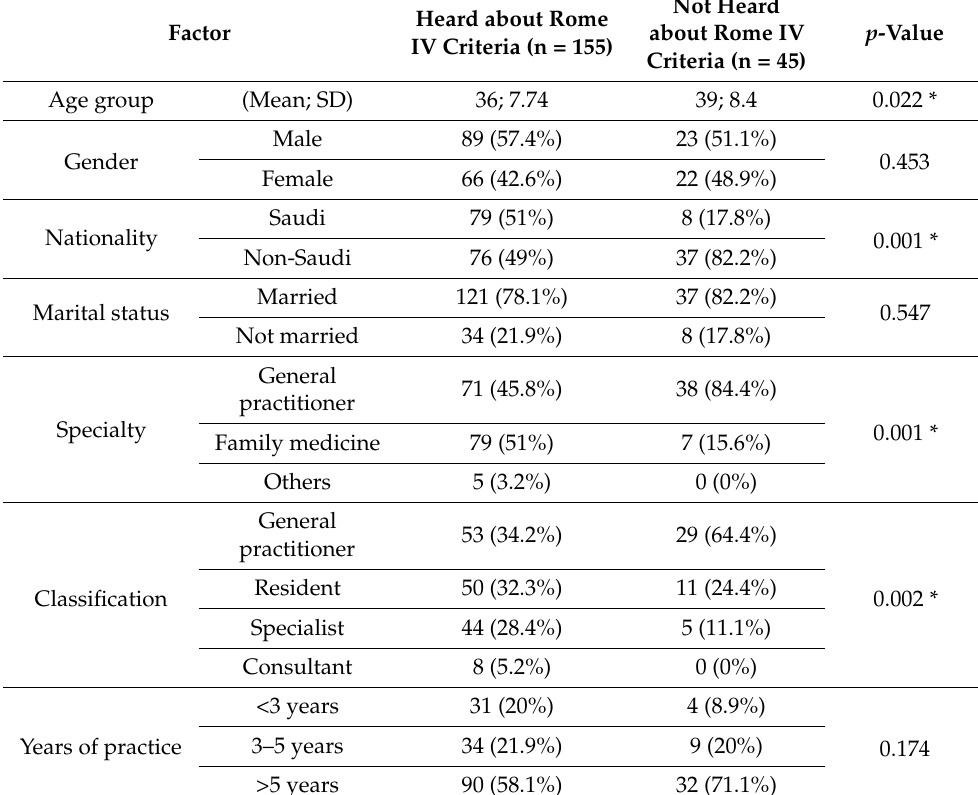
Table 2. Awareness of ROME IV criteria among the included participants (n = 200).